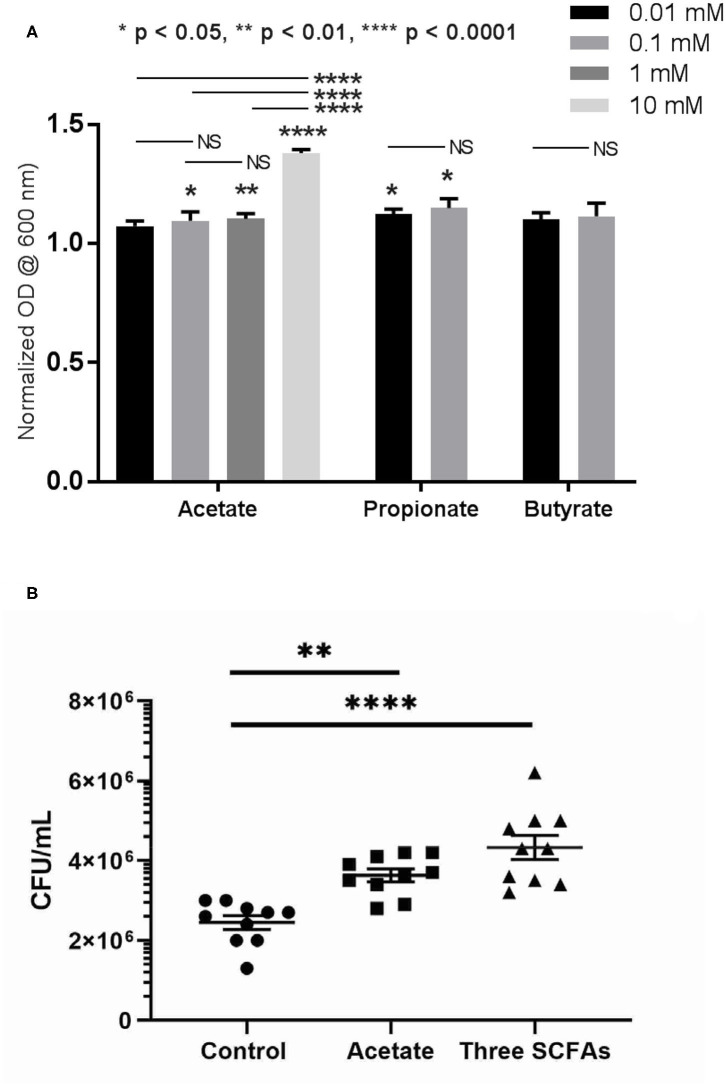
Growth of PAO1 with SCFAs. (A) PAO1 growths were compared to controls in the presence of different concentrations of acetate (between 0.1 and 10 mM): normalizzed OD values at 600 nm: 0.01 mM = 7.3 ± 0.02 (n = 4), 0.1 mM = 9.6 ± 0.04 (n = 4), 1 mM = 11.04 ± 0.02 (n = 4), and 10 mM 13.8 ± 0.02 (n = 4). In the presence of propionate, statistical significance was noted in both concentrations compared to controls (Normalized OD values at 600 nm: 0.01 mM = 12.3 ± 0.02 (n = 4), 0.1 mM = 15 ± 0.04 (n = 4). However, no statistically significant growth of PAO1 was seen with butyrate at these two concentrations [0.01 mM = 10 ± 0.03 (n = 4), 0.1 mM = 11.5 ± 0.05 (n = 4), p = 0.096]. (one-way ANOVA, NS = no significance). (B) Colony counts were significantly higher when PAO1 strains were grown with acetate alone or three SCFAs compared to controls (Control = 2.45 × 106 ± 1.7 × 105 CFU/ml (n = 10), Acetate = 3.63 × 106 ± 1.58 × 105 CFU/ml (n = 10), 3 SCFAs = 4.33 × 106 ± 3.0 × 105 CFU/ml (n = 10), ANOVA, p < 0.0001, (*p < 0.05, **p < 0.01, and ****p < 0.0001).